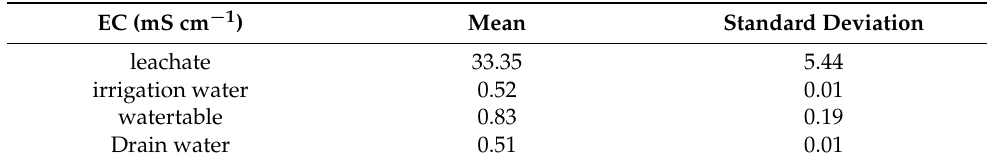
Table 2. Mean electrical conductivity and standard deviation for leachates, irrigation water, drain water and watertable around the landfill.